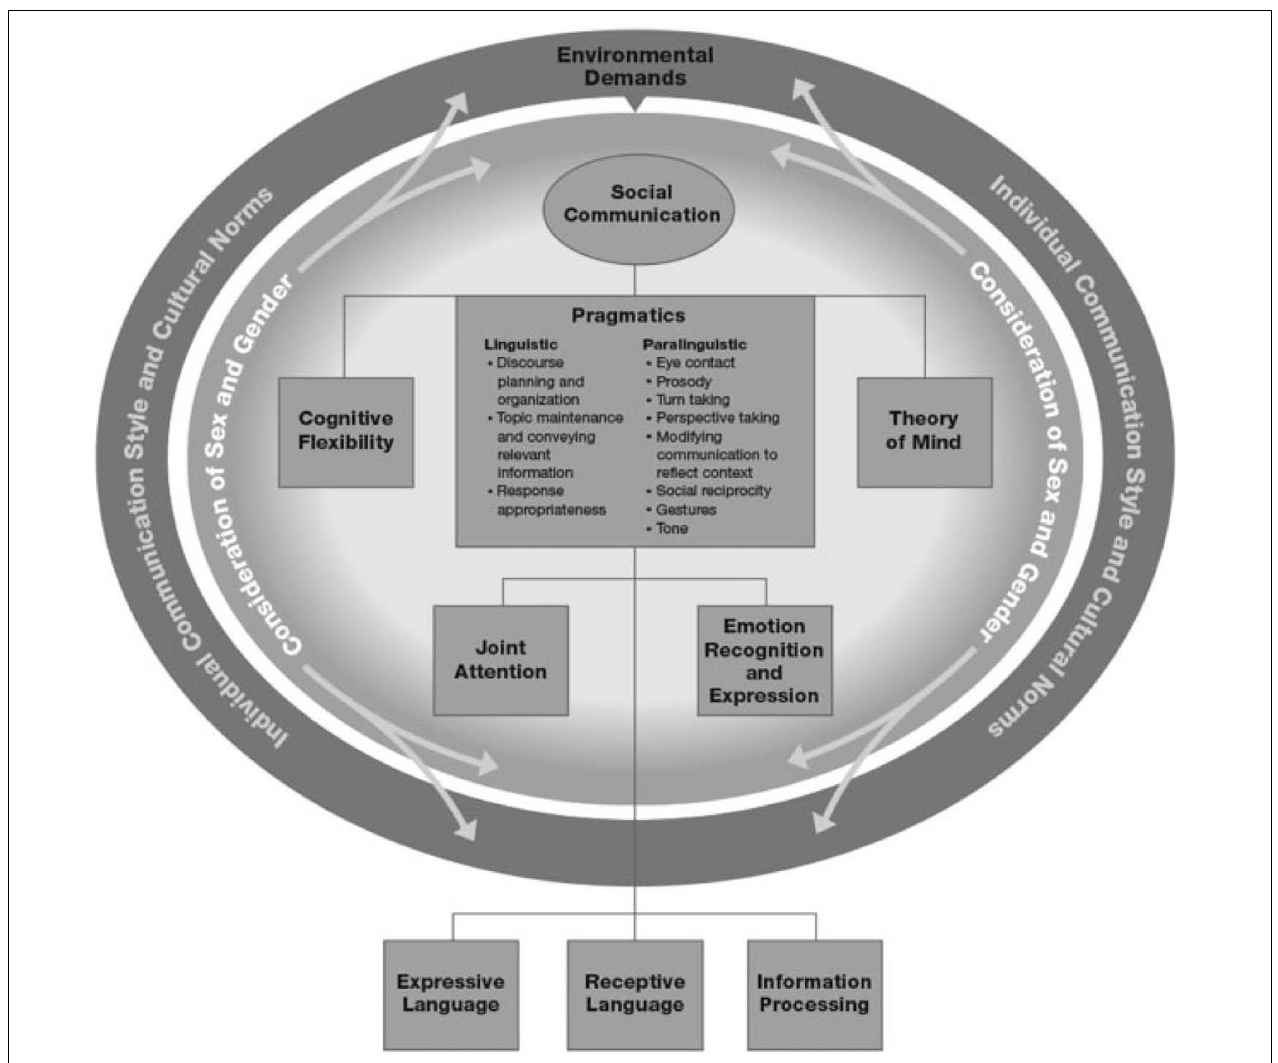
FIGURE 1 | Social communication model (SoCom) (used with permission from the publisher, Georg Thieme Verlag